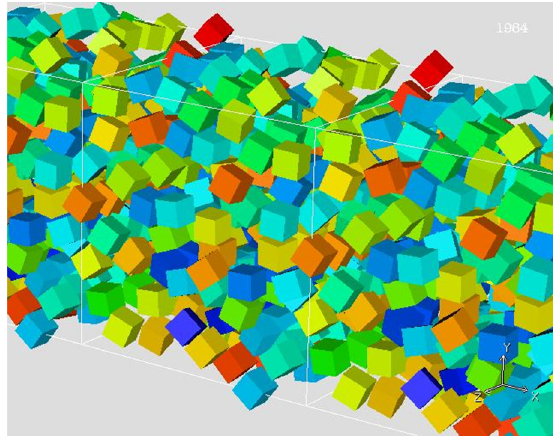
Figure 4. Simulation of the flow of a suspension of cubical particles [Nicos Martys, personal